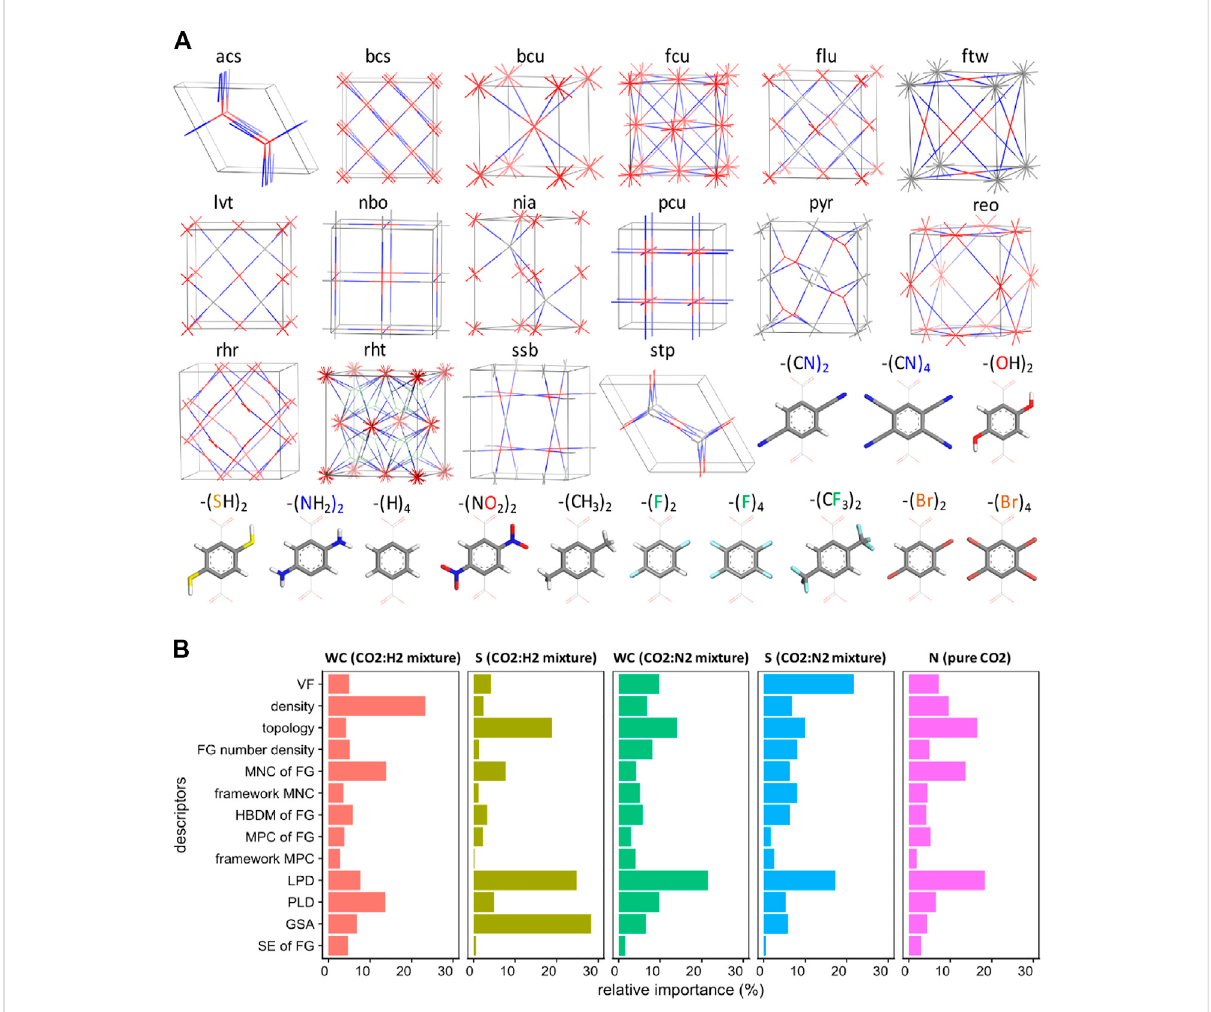
FIGURE 5 (A) Topological blueprints and connecting molecular building blocks used in the construction of the over 400 MOF designs, and (B) Relative importance of material descriptors obtained from GBM training (S = selectivity, WC = working capacity, N = adsorption loading. FG =